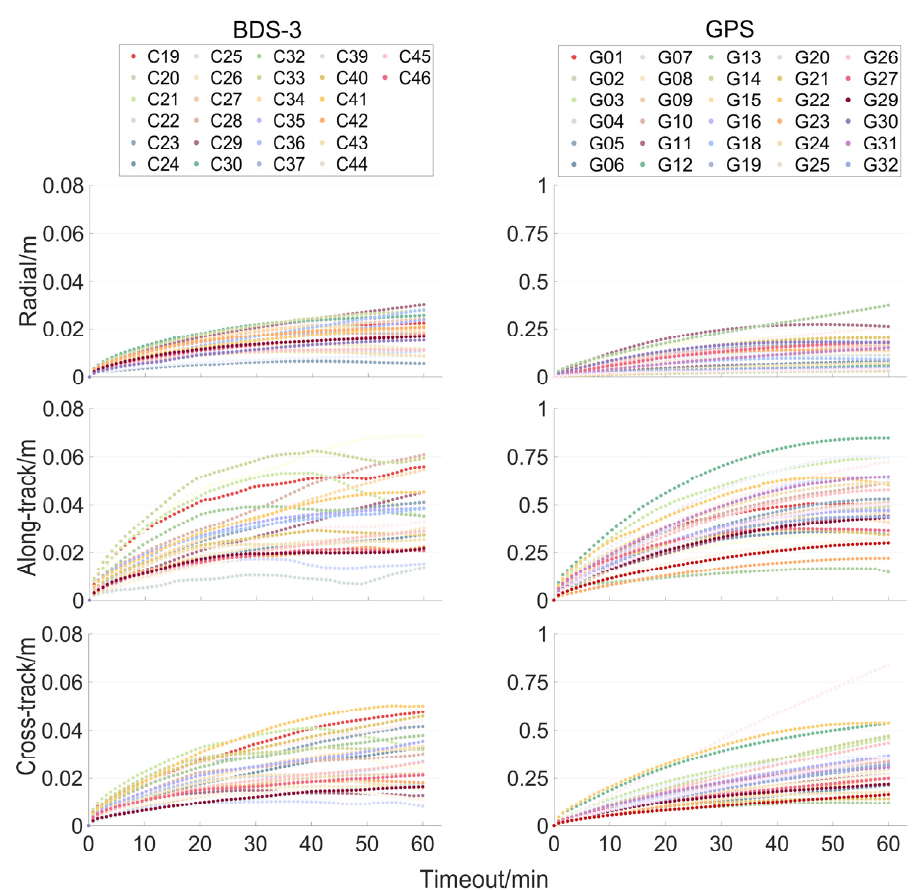
Figure 10. RMSE of the extended orbit corrections of the BDS-3 and GPS satellites in the radial, along-, and cross-track directions on DOY 192 in 2022.